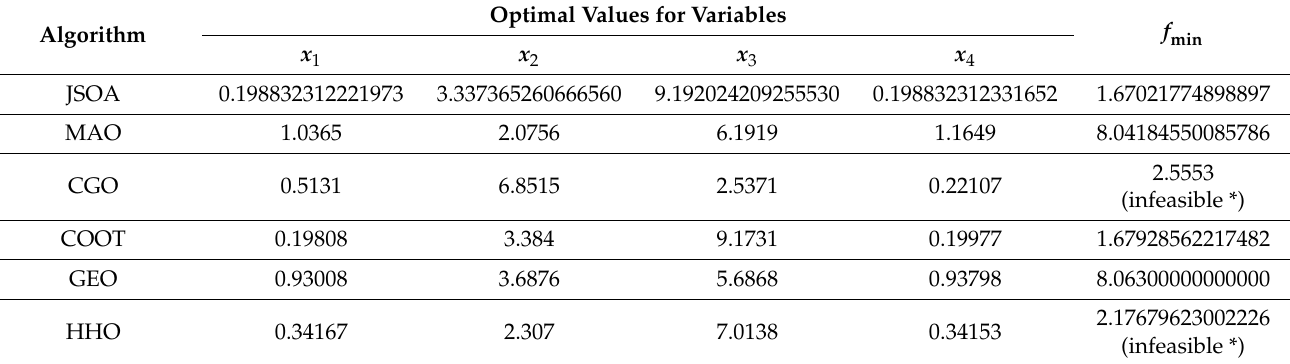
Table 9. Comparison results for Welded Beam